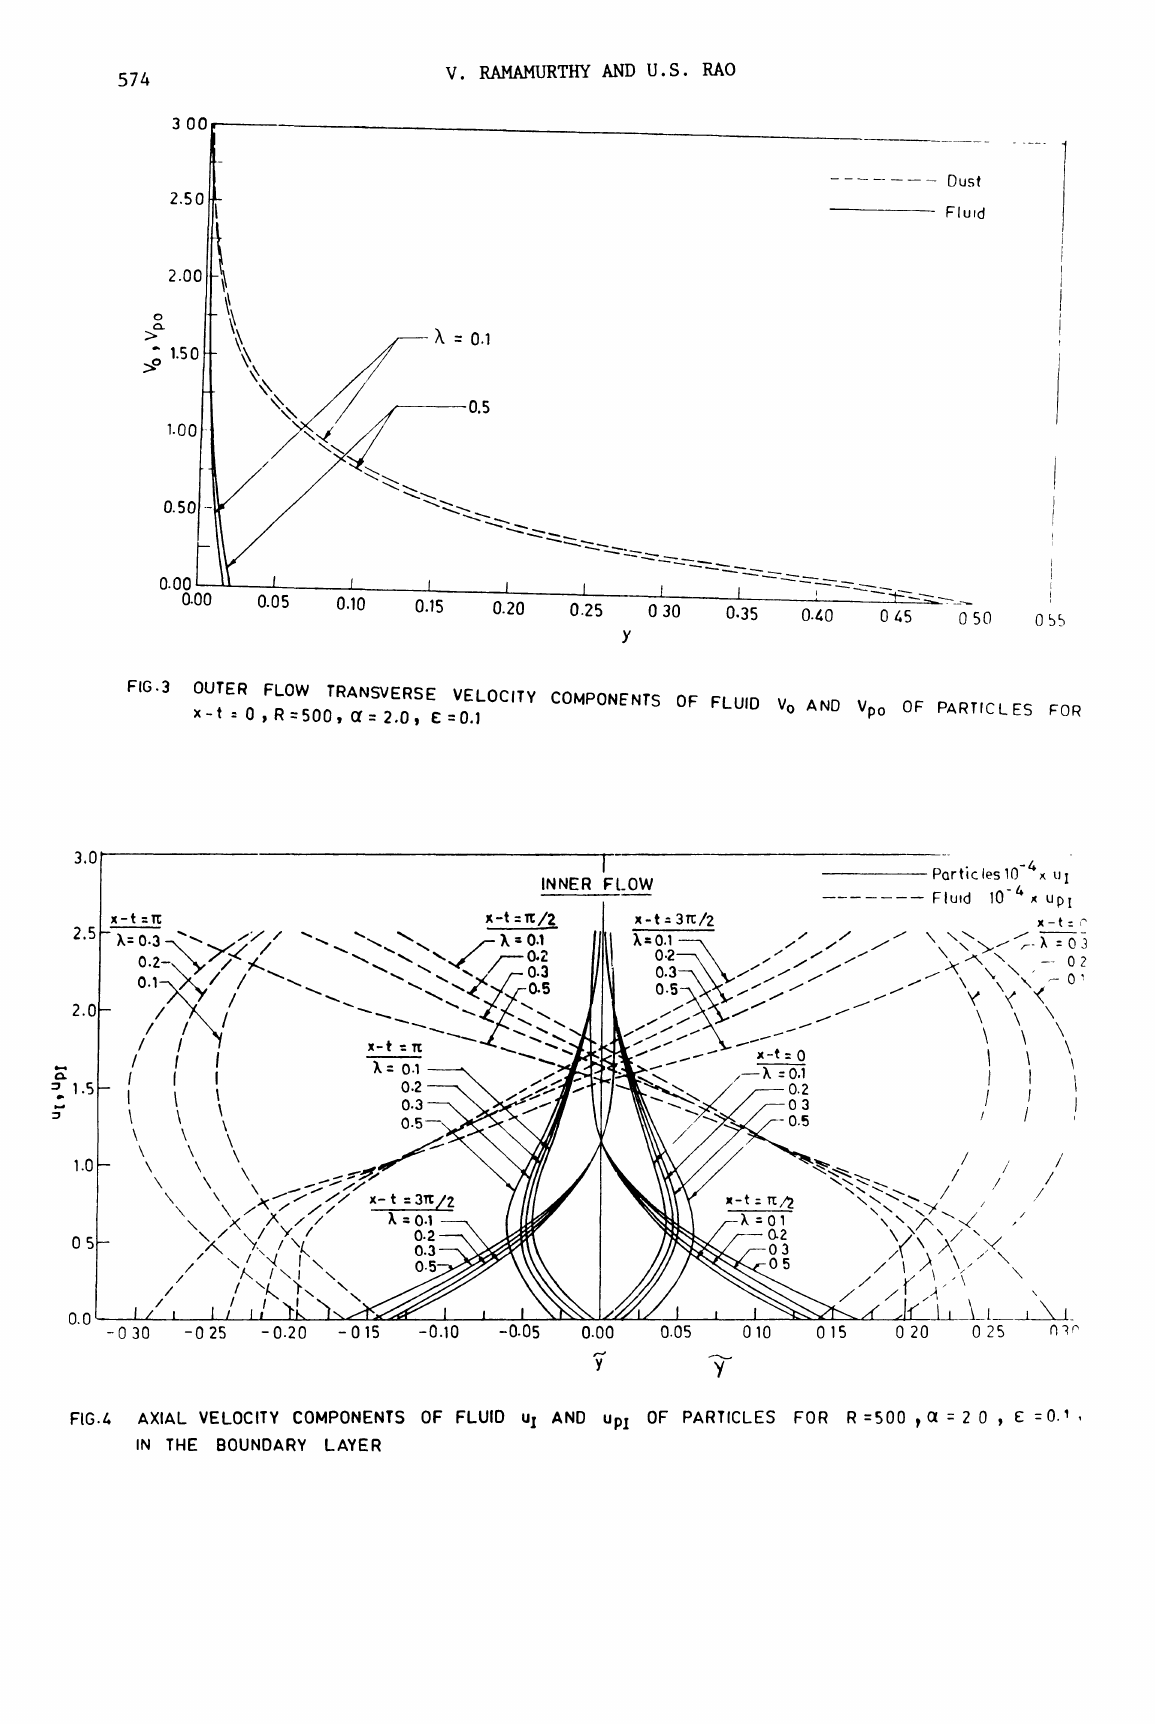
OF FLUID Vo AND Vpo OF PARTICLES FOR